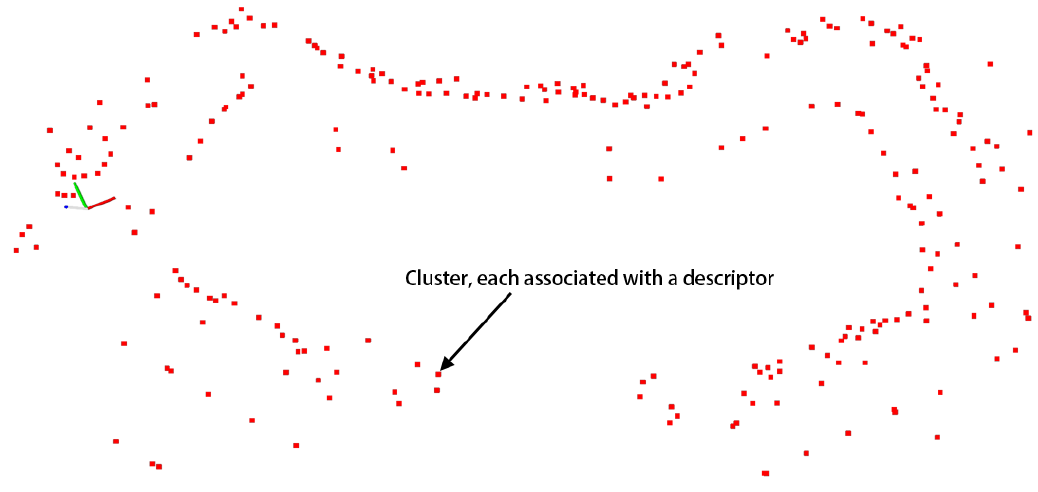
Figure 3. Building of 2D ClusterMap by projecting all clusters to a 2D horizontal